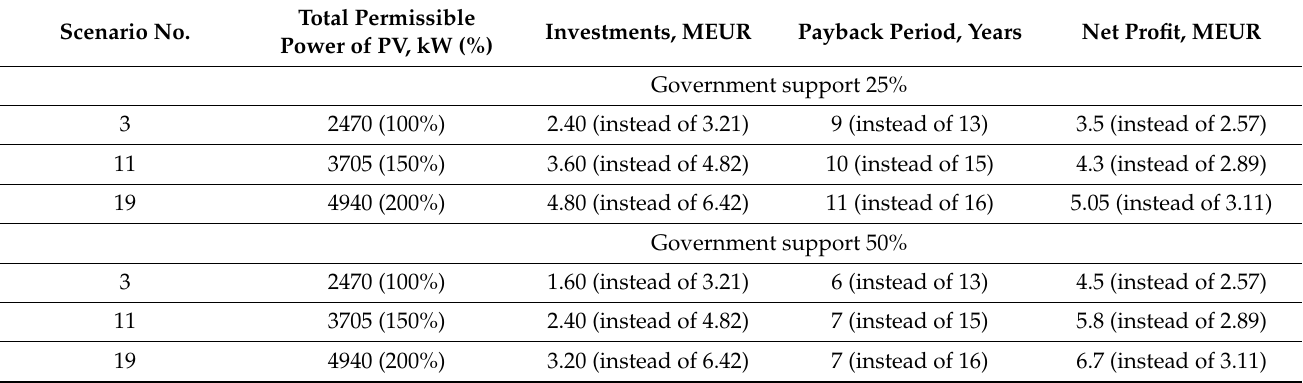
Table 3. A comparison of the financial findings, applying government